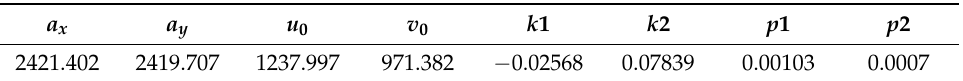
Table 2. Intrinsic parameters of